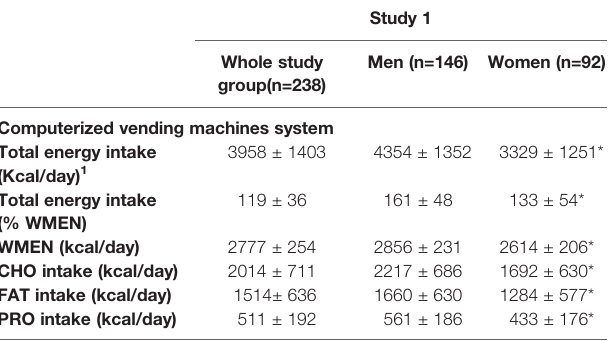
TABLE 2 | Measures of ad libitum food intake by the computerized vending machine system.